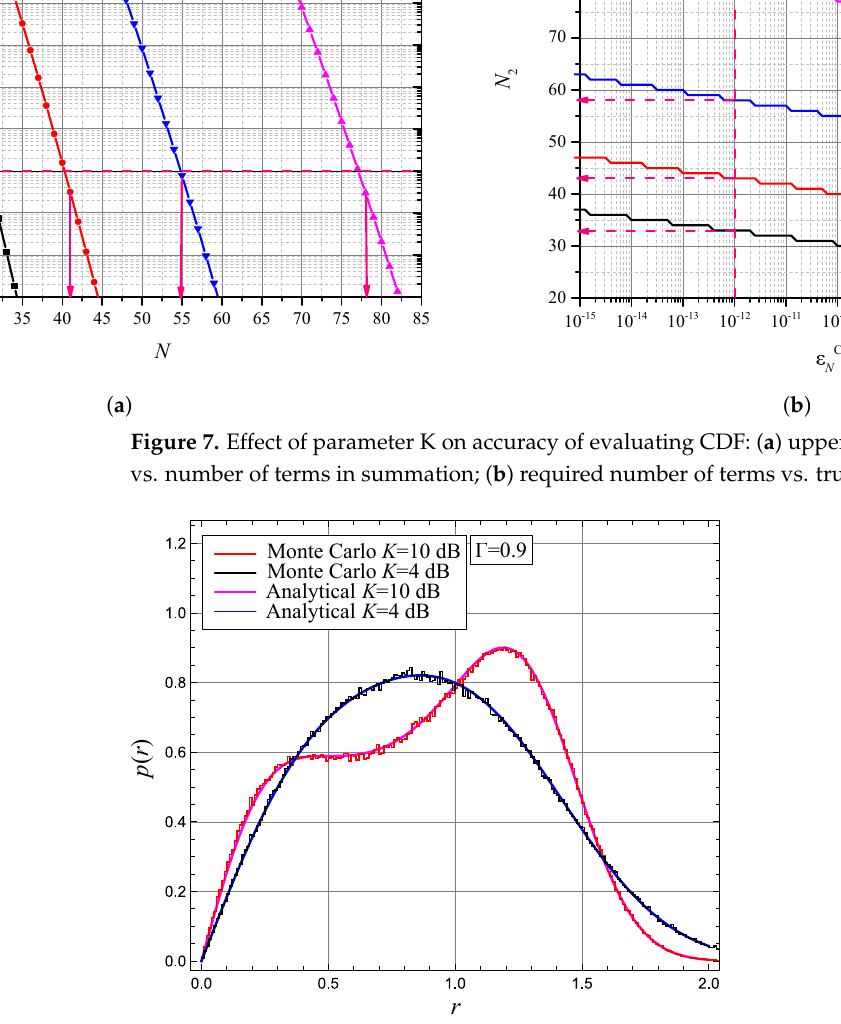
Figure 8. Analytical and Monte Carlo simulation